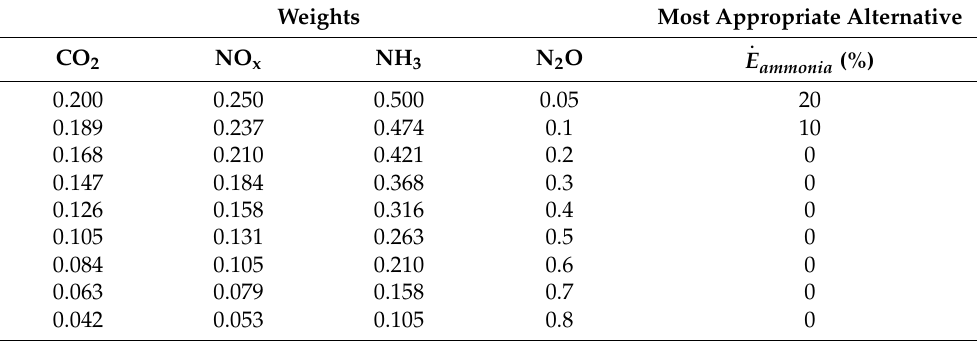
Table 4. Most appropriate percentage of power contribution from ammonia for different combinations of